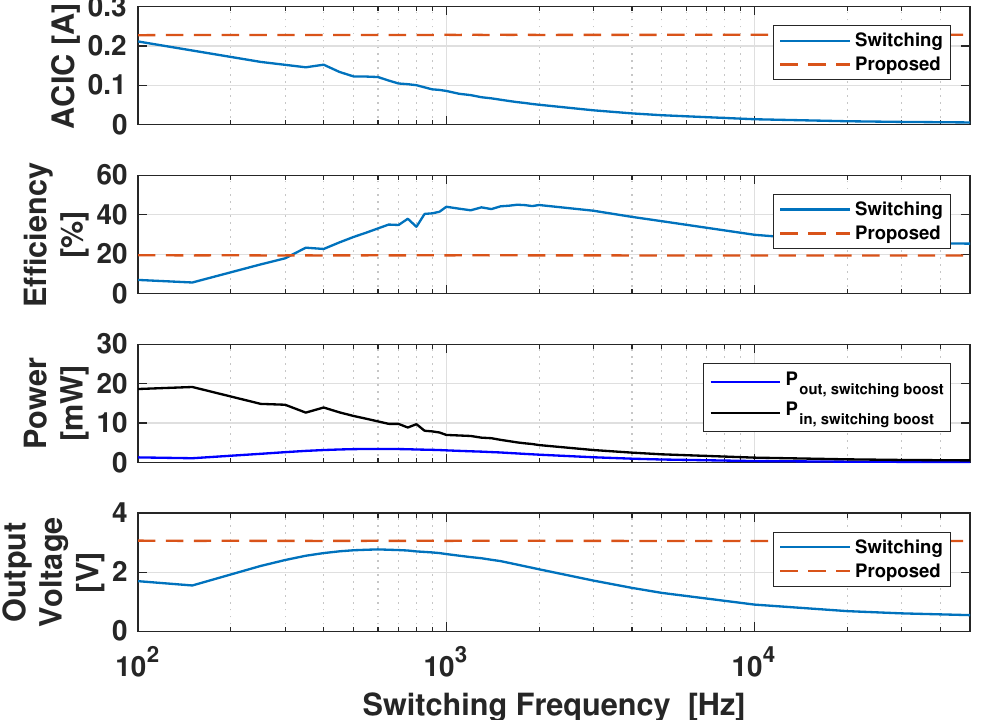
Figure A1. Performance comparison between the proposed switching method based on the Arduino board and the HFS method. From top to bottom pane: average commutation inductor current (ACIC), efficiency, input and output power of the HFS boosting technique, output